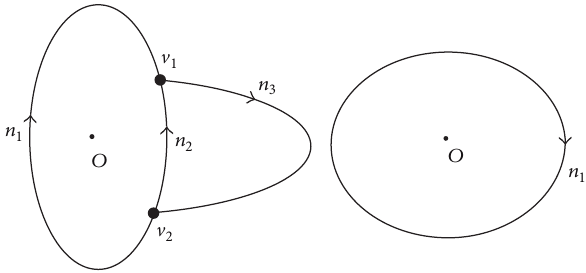
𝑛 𝑘 , charge conservation at vertex